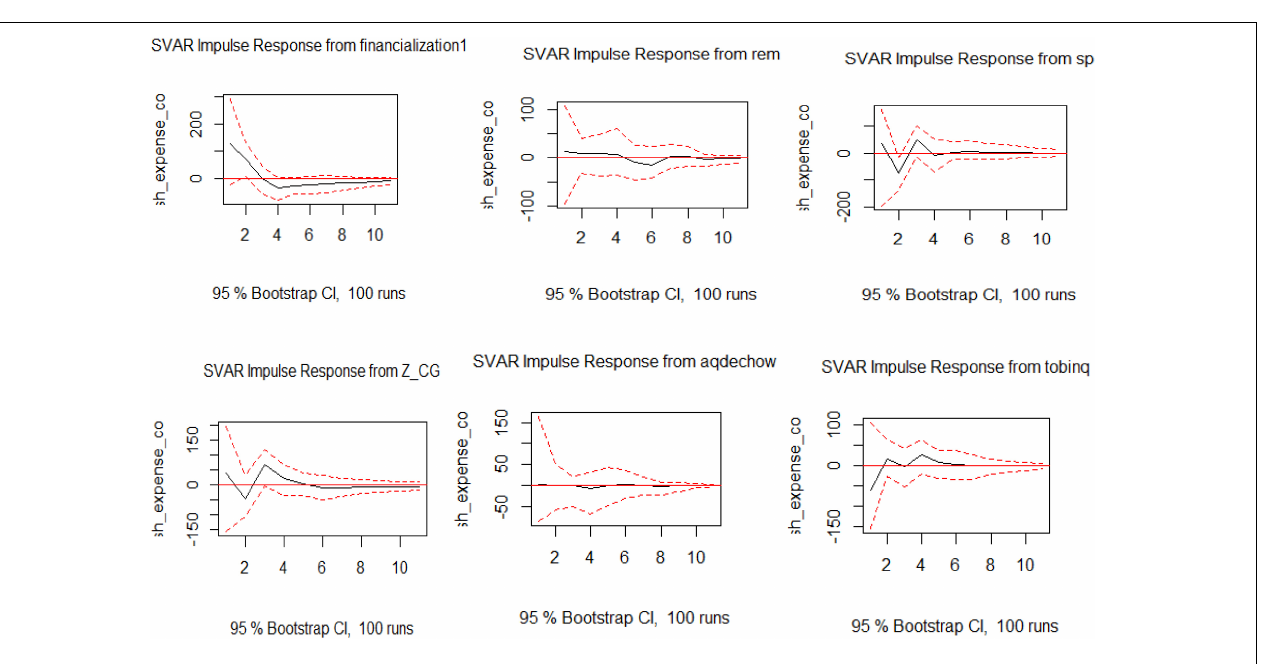
FIGURE 4 | Visualization of IRF for SVAR for Model